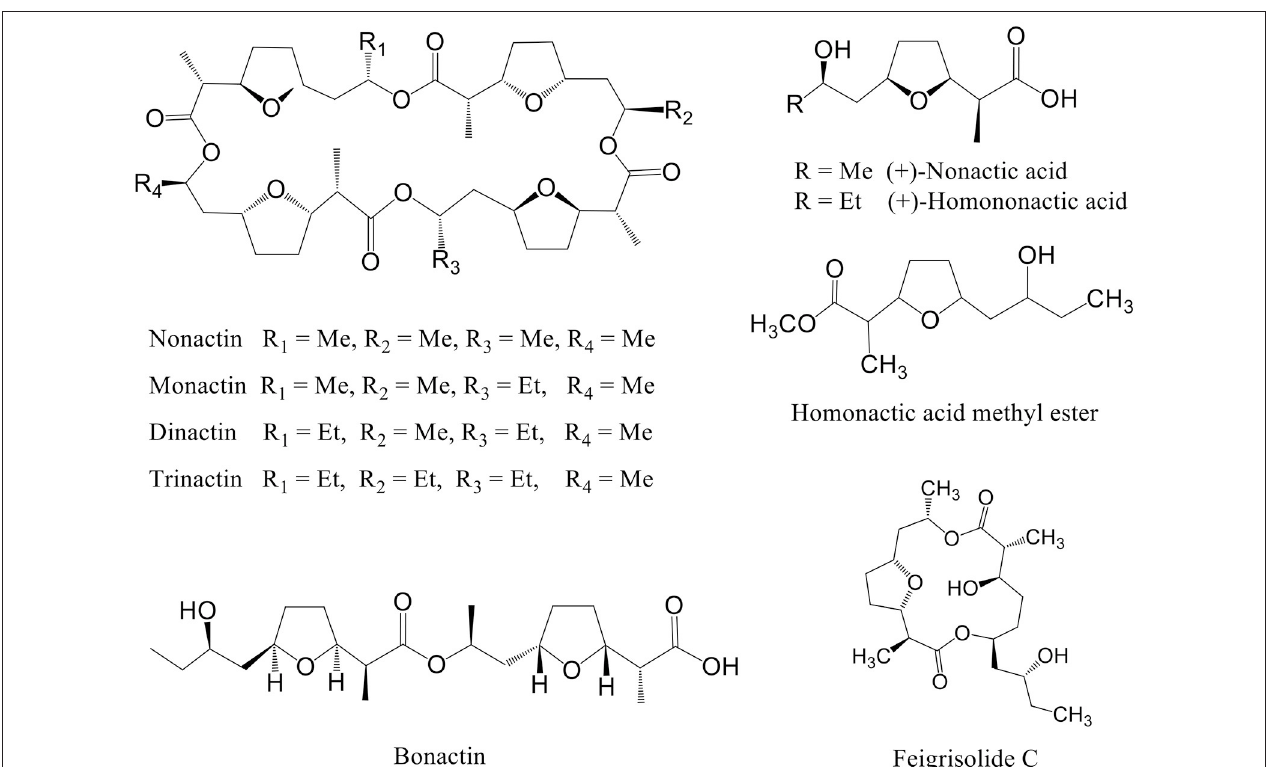
FIGURE 1 | Structure of secondary metabolites isolated from marine Streptomyc es spp. having motility inhibitory and lytic activities against peronosporomycete zoospores.